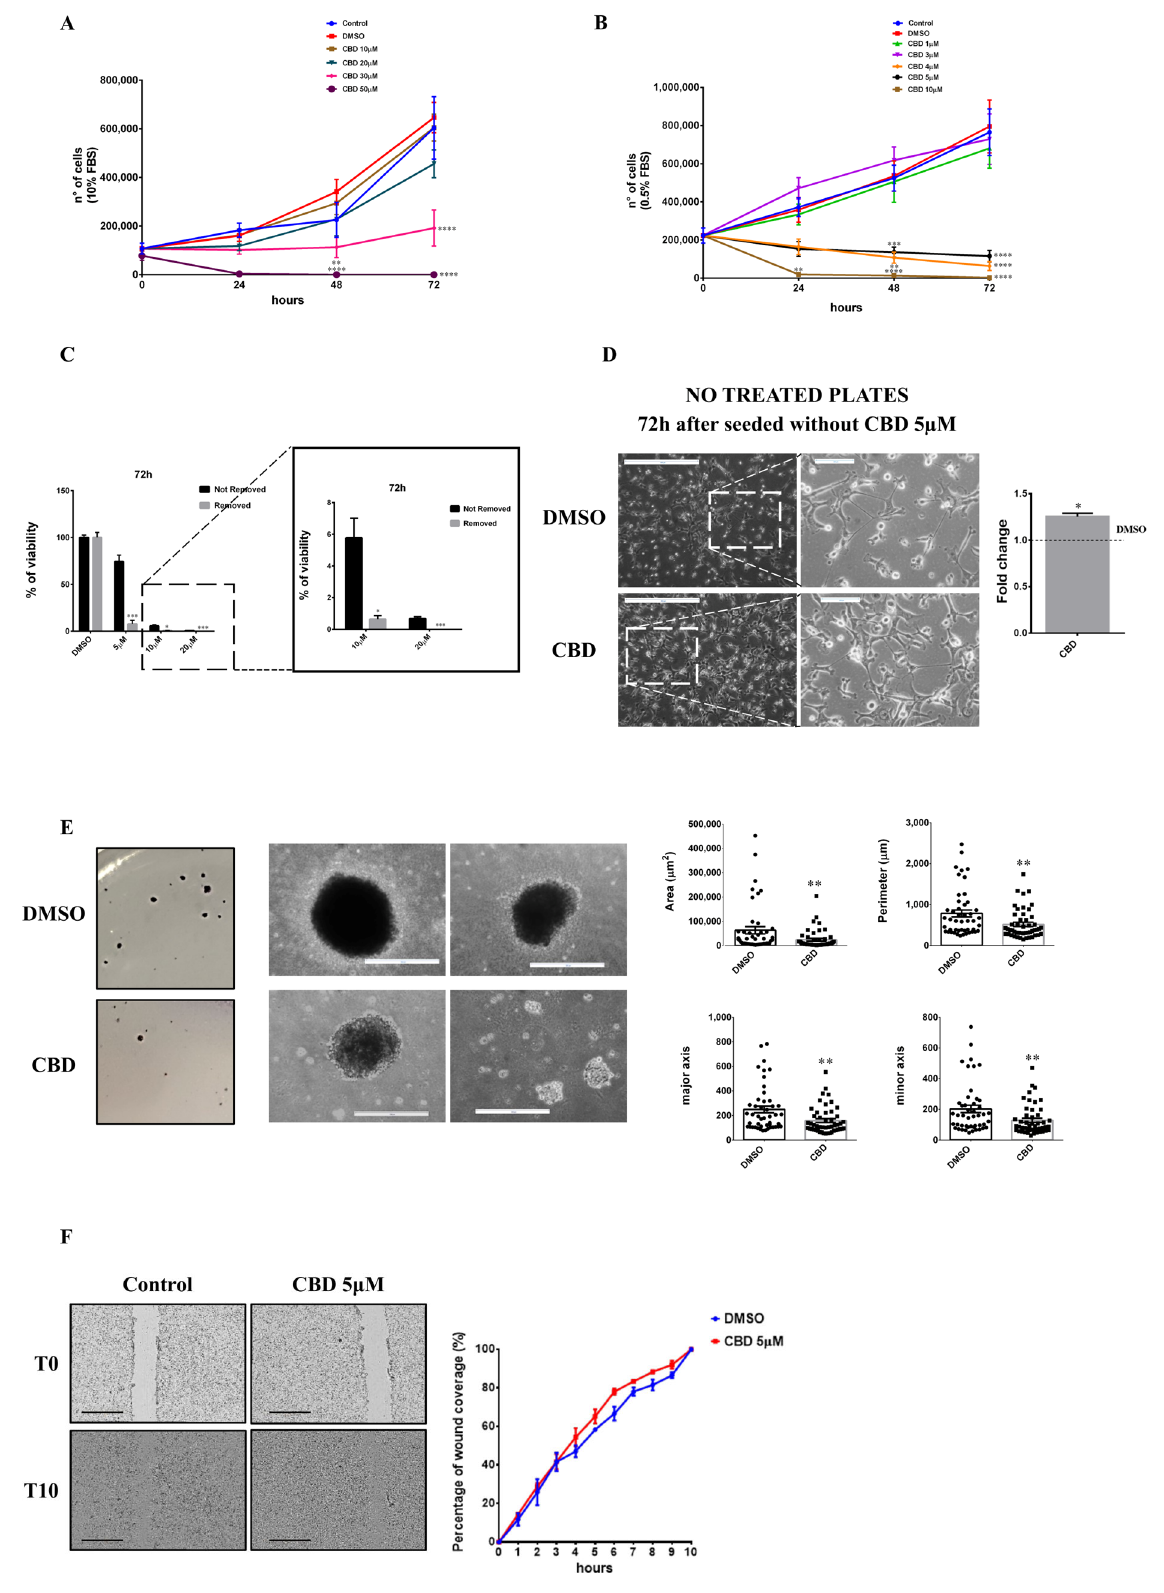
Figure 1. Effects of CBD treatment on MDA ‐ MB ‐ 231 cells. MDA ‐ MB ‐ 231 cells were plated on 24 ‐ well plates. After 24 h, cells were treated with different concentrations of CBD in DMEM medium supplemented with 10% FBS ( A ) or in DMEM medium supplemented with 0.5% FBS ( B ). The num ‐ ber of viable cells was determined at 0, 24, 48, and 72 h. ( C ) MDA ‐ MB ‐ 231 cells were plated on 96 ‐ well plates. The day after, cells were treated with different concentrations of CBD in DMEM with